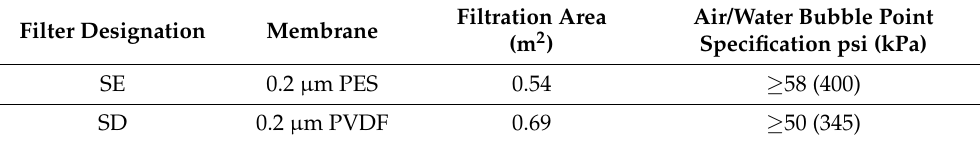
Table 1. Sterilizing-grade pleated cartridge